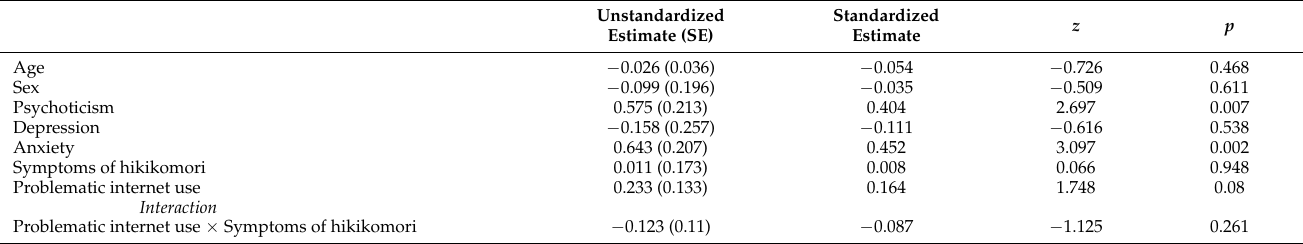
Table 6. Completely standardized latent associations between the factors representing the indepen- dent variables of interest and distress due to PLEs as a dependent